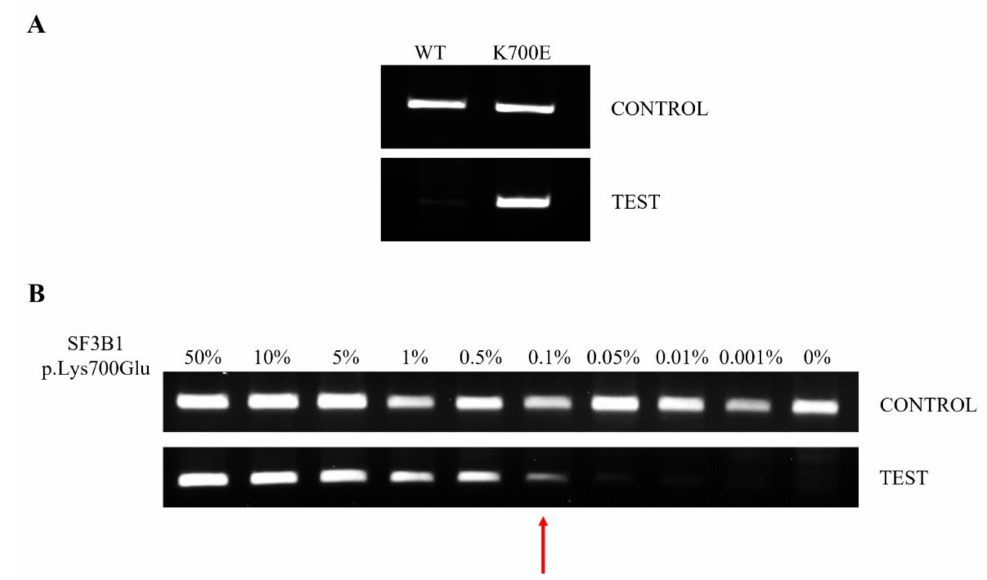
Figure 2. Electrophoretic runs of PCR reactions: each amplicon was loaded on 2% agarose-TBE 1 × gel with 5 µ g/mL EtBr and run at 150 V for 30 min. PNA-PCR clamping for SF3B1 was carried out in the absence (CONTROL) and presence (TEST) of the PNA probe. ( A ) Example of PNA- PCR clamping in DNA from WT and p.Lys700Glu-mutated patients. CONTROL PCR represents an internal control and DNA must always be amplified. TEST PCR returns the result about the mutational status of SF3B1 ; if the patient is SF3B1 WT, the gDNA is not amplified, while if the patient is SF3B1 p.Lys700Glu, the gDNA is amplified. ( B ) PNA-PCR clamping LoD was assessed by mixing pGEMT- SF3B1 p.Lys700Glu and pGEMT- SF3B1 WT plasmids at different ratios in the same PCR reaction. Dilutions were as follows: 50, 10, 5, 1, 0.5, 0.1, 0.05, 0.05, 0,01, 0.001 and 0% pGEMT- SF3B1 p.Lys700Glu, all brought to 100% with the respective amount of pGEMT- SF3B1 WT template. The percentage of the mutated template is indicated above each amplicon. The red arrow indicates the LoD of the PNA-PCR clamping